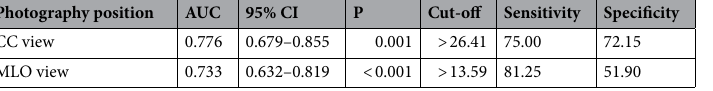
Table 3. Analysis of the diagnostic value of CC and MLO views grey value reduction percentages.